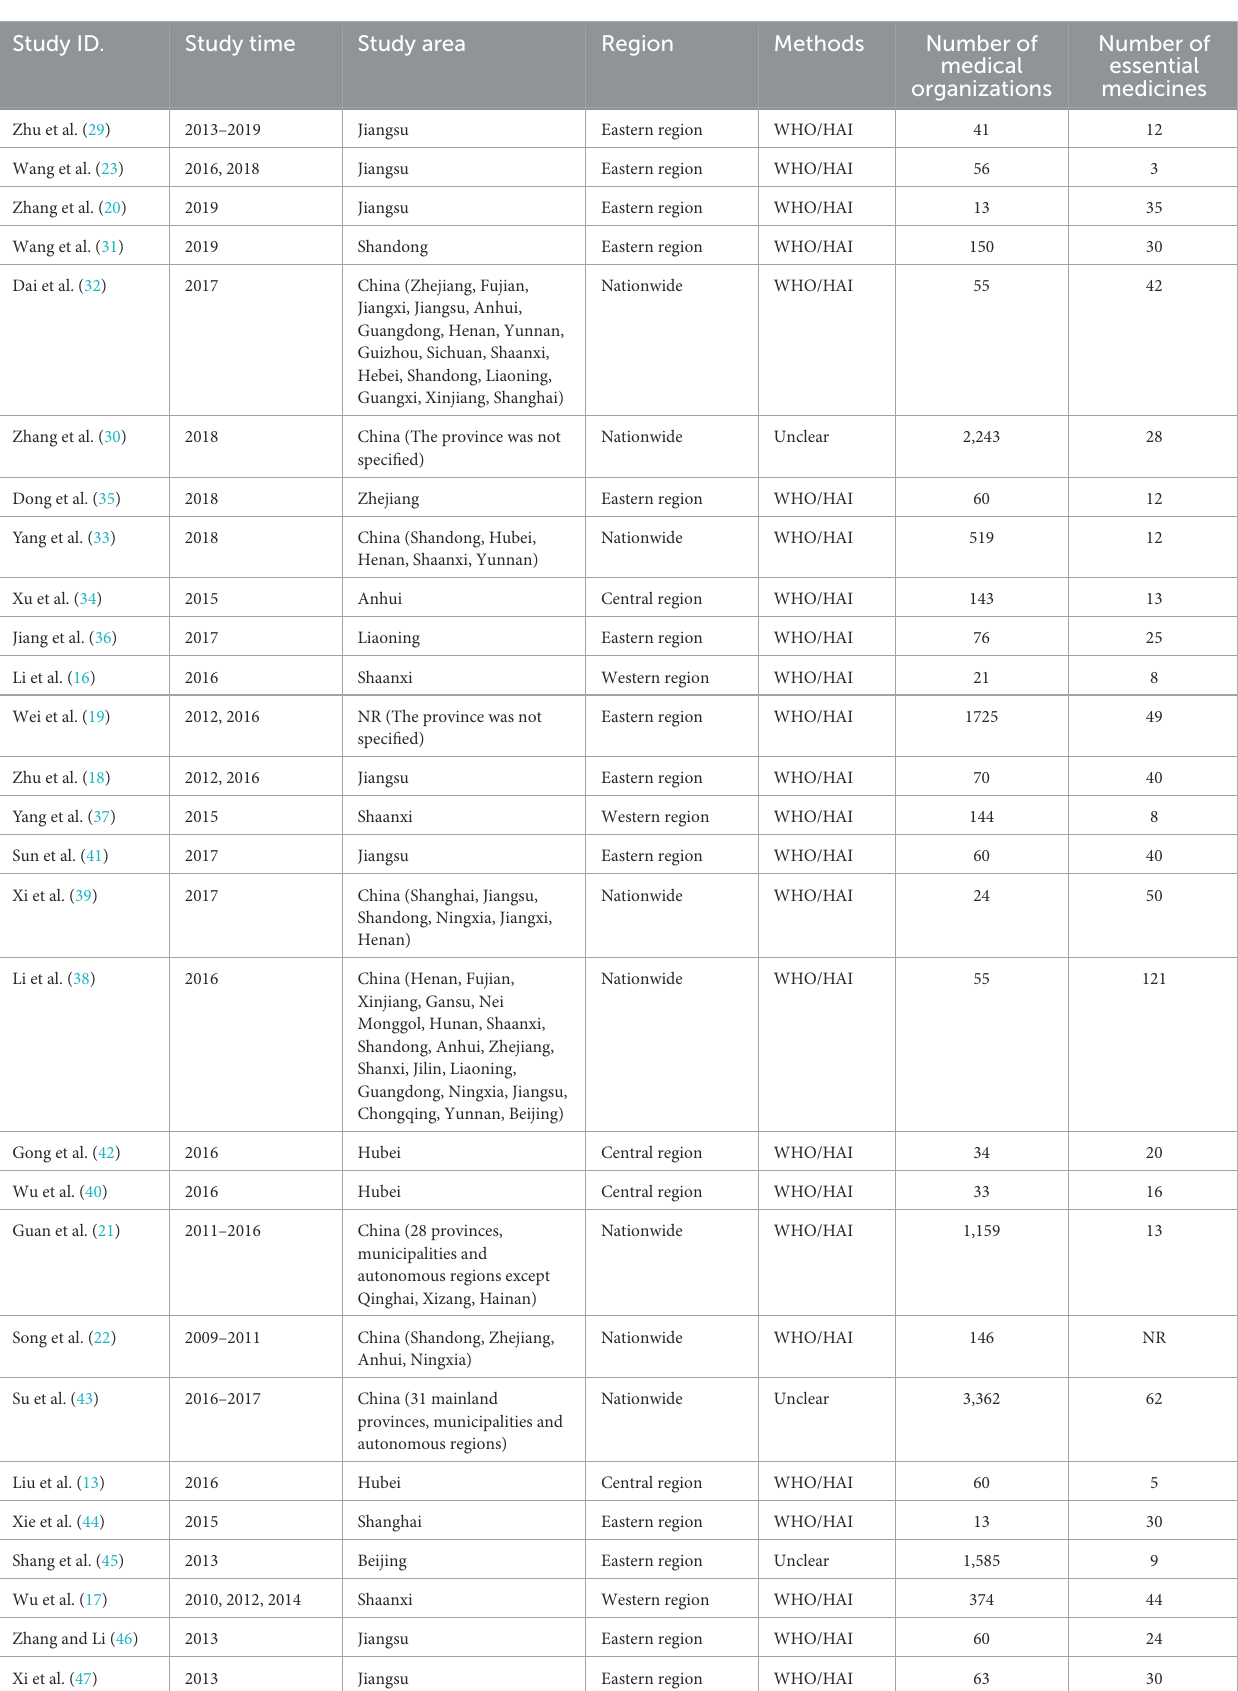
TABLE 1 Characteristics of included studies. Study